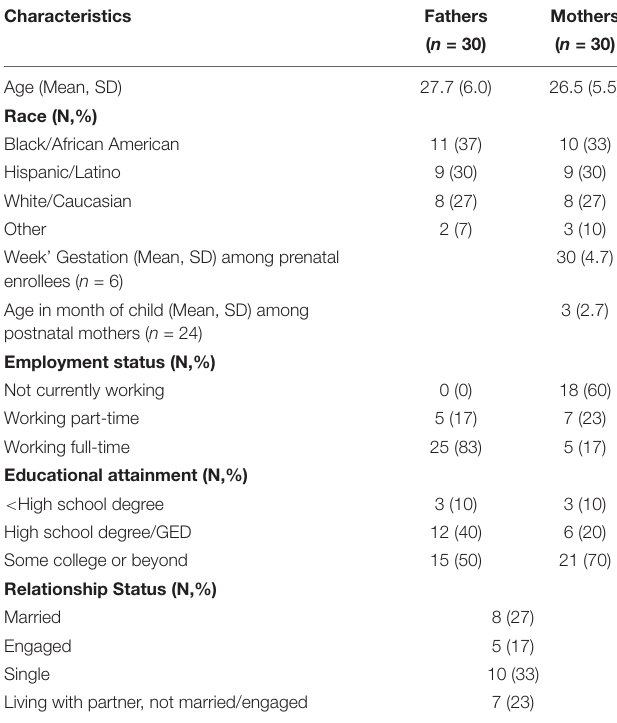
TABLE 1 | FAB pilot participants: baseline demographic characteristics.